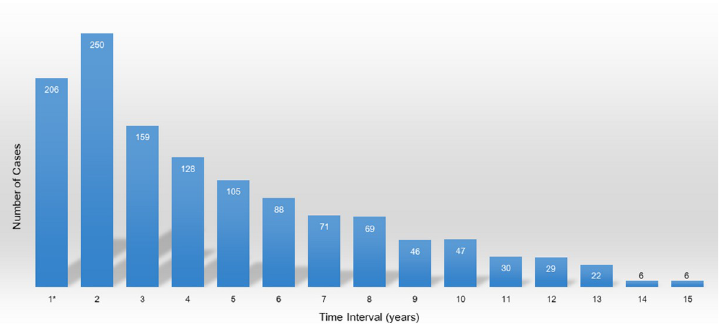
Fig 1. Time interval between breast cancer and thyroid cancer 1 � : Only the second half of the first year.